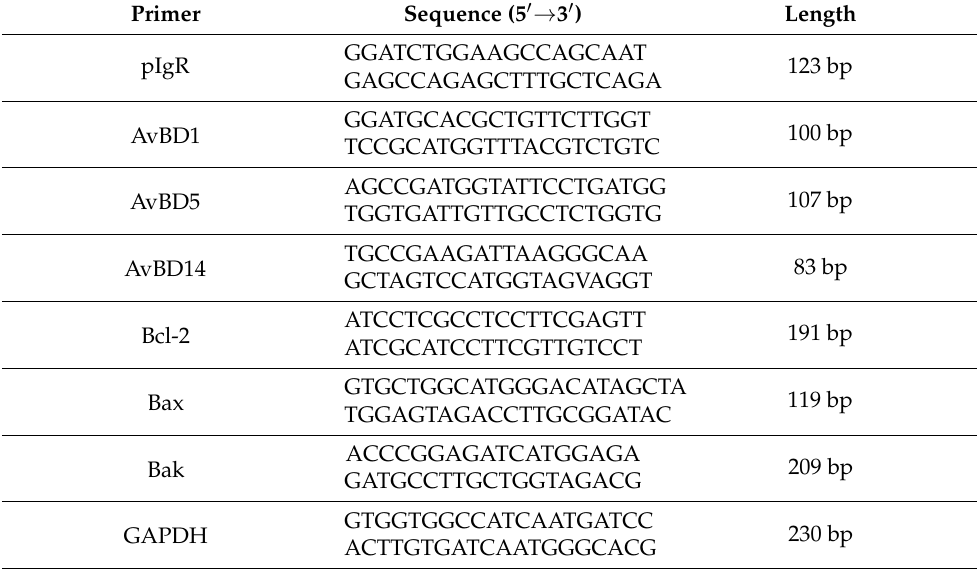
Table 2. Gene sequences in real-time PCR primers.